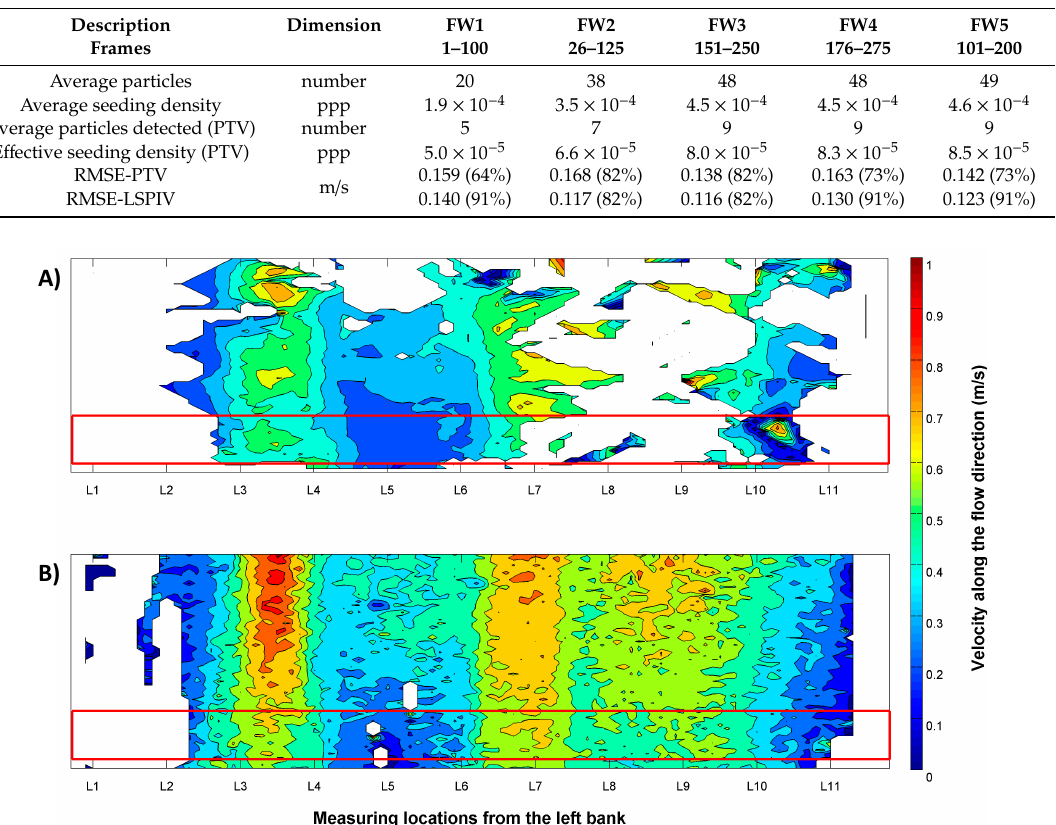
Table 6. Average seeding characteristics of frame sequences with RMSE computed with di ff erent techniques. Percentage of locations with estimated value using image velocimetry techniques shown in parentheses.